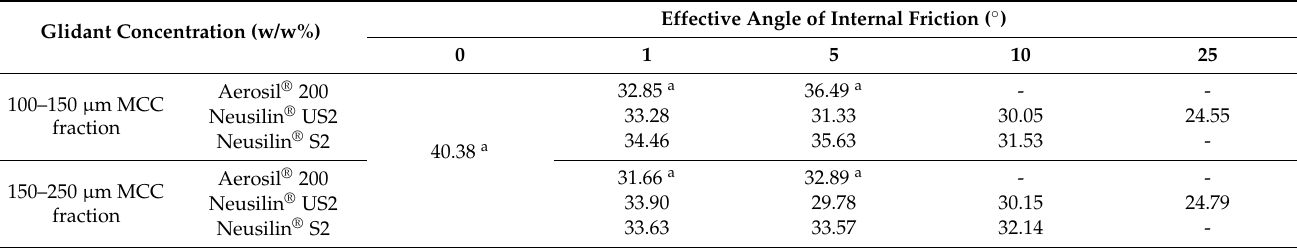
Table 4. Values of effective angle of internal friction for pure compounds and prepared binary mixtures. Glidant Concentration